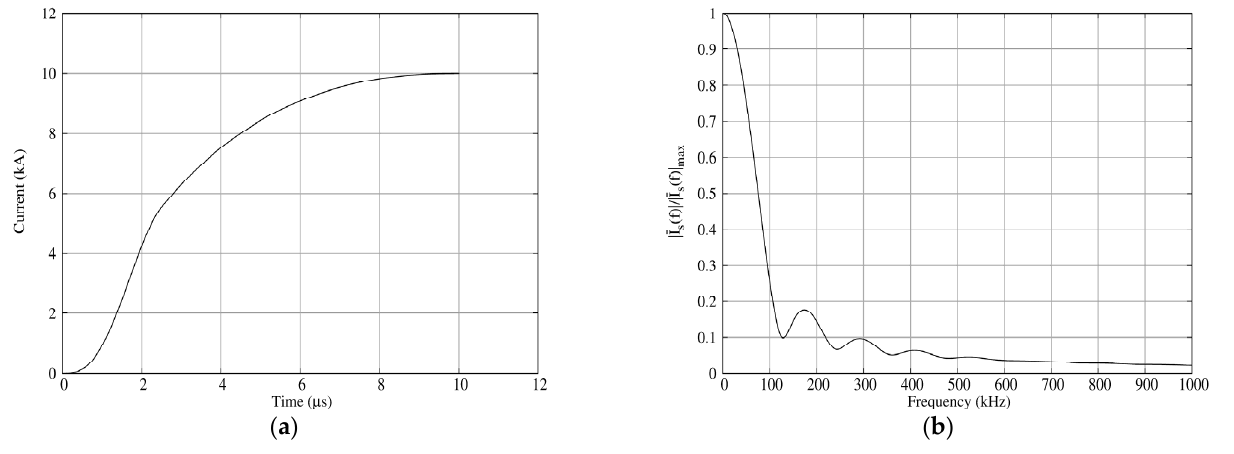
Figure 5. Lightning current excitation source: ( a ) 𝐼 (cid:3046) (𝑡) (time domain) truncated at 10 μs and ( b ) normalized Fourier transform of 𝐼 (cid:3046) ( 𝑡 ) , calculated between 0 and 1 MHz.